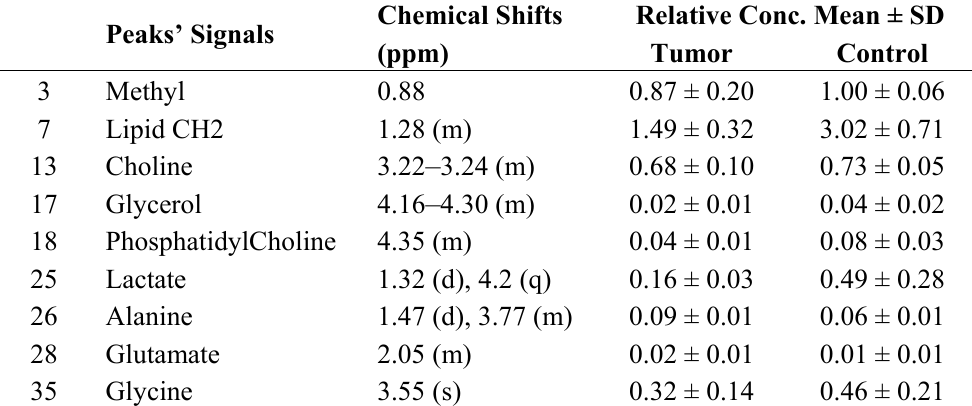
Table 2. Peak Assignments of Metabolites in HR-MAS